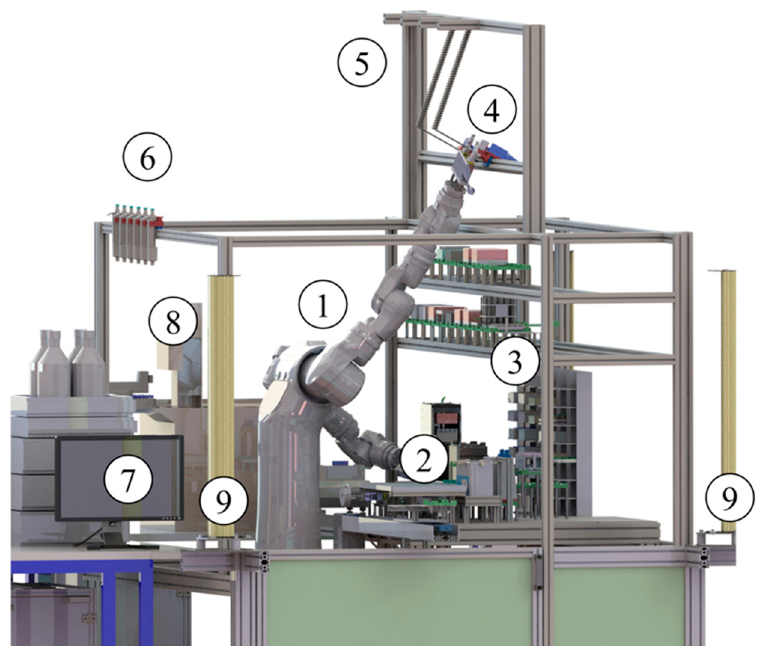
Figure 1. Robotic system for automated sampled preparation and analytical measurements: ( 1 ) Dual–arm robot CSDA10F grasping a pipette using the right arm; ( 2 ) workbench with automated labware positioners (ALP), laboratory devices, and equipment; ( 3 ) multi–level storage system; ( 4 ) electronic pipettes mounted in front of the robot; ( 5 ) cable guide for electronic pipettes; ( 6 ) conventional manual pipettes mounted behind the robot; ( 7 ) measurement system 1 (LC/MS); ( 8 ) measurement system 2 (GC/MS); and ( 9 ) safety system with light curtain.